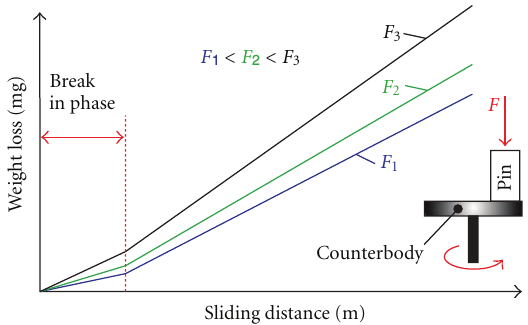
Figure 4: Pin-on-disc concept—break in